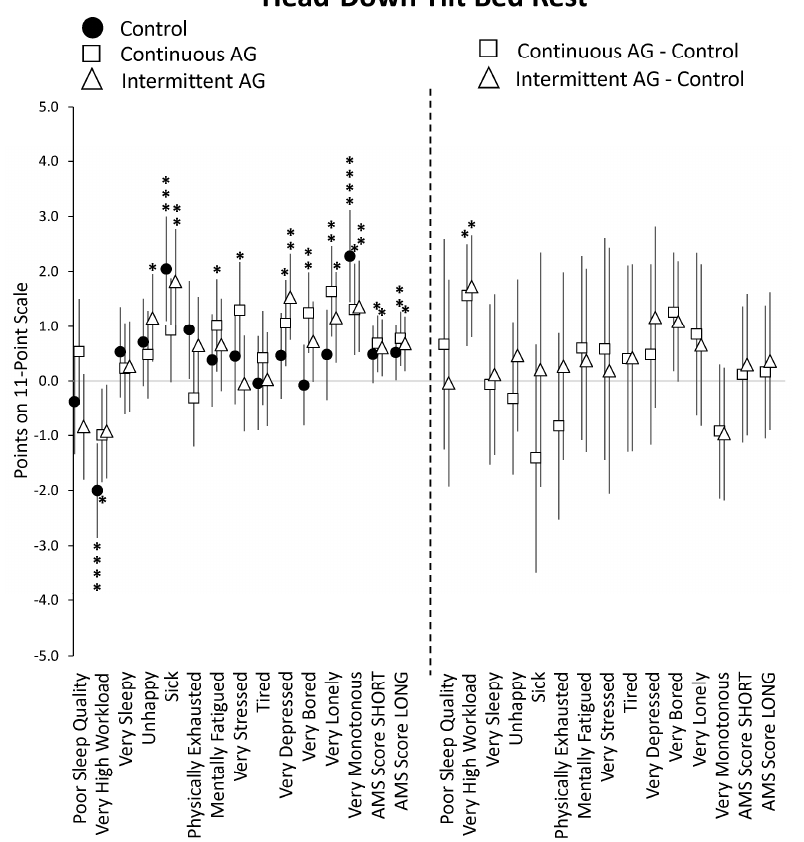
Figure 3. Change in survey responses during head-down tilt bed rest (HDBR) relative to pre-HDBR baseline for the control group (black circles), continuous artificial gravity group (white squares), and intermittent artificial gravity group (white triangles). Estimates reflect points on an 11-point scale. For each variable, the negative response anchor is shown (e.g., “unhappy”, “sleepy”). Positive scores reflect more negative assessments relative to baseline (graphs on the left) or control (graphs on the right). Error bars reflect unadjusted 95% confidence intervals. Adapted from Basner et al. [16] with permission. * adjusted p < 0.05; ** adjusted p < 0.01; *** adjusted p < 0.001; **** adjusted p < 0.0001.